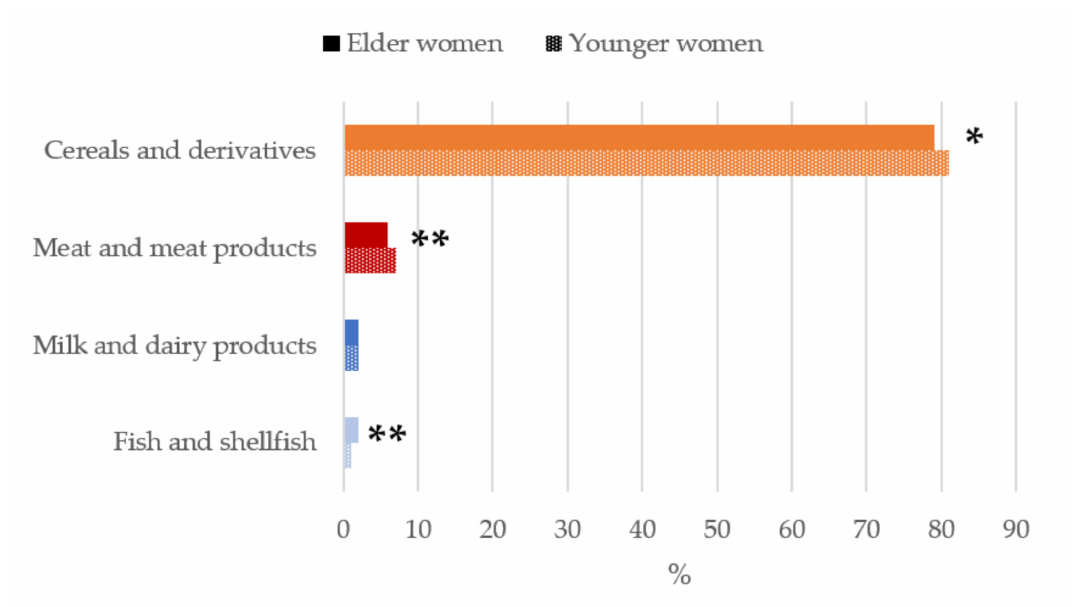
Figure 2. Contribution of main sources (food and beverages) to betaine intake in women of childbearing age from the ANIBES study by age-group. * p < 0.05 difference vs. younger women (Mann–Whitney’s U test). ** p < 0.01 difference vs. younger women (Mann–Whitney’s U test).